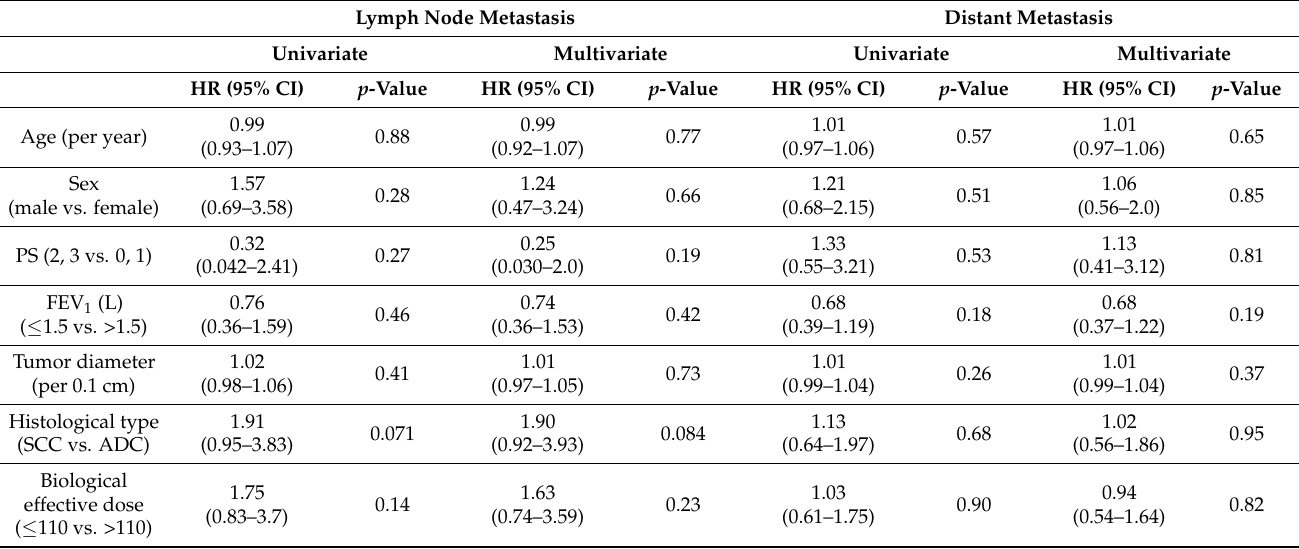
Table A1. Univariate and multivariate analyses of lymph node metastasis and distant metastasis. Lymph Node Metastasis Distant